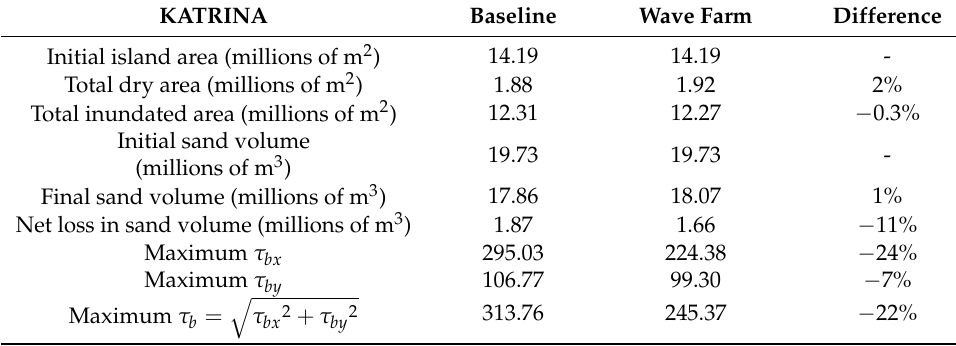
Table 2. Inundated and dry areas, initial and final sand volume, net loss in sand volume, and maximum bed shear stress values in x- and y-directions [N/m 2 ] for Dauphin Island, AL averaged over time in the mid-domain nearshore area for Hurricane Katrina under baseline and wave farm